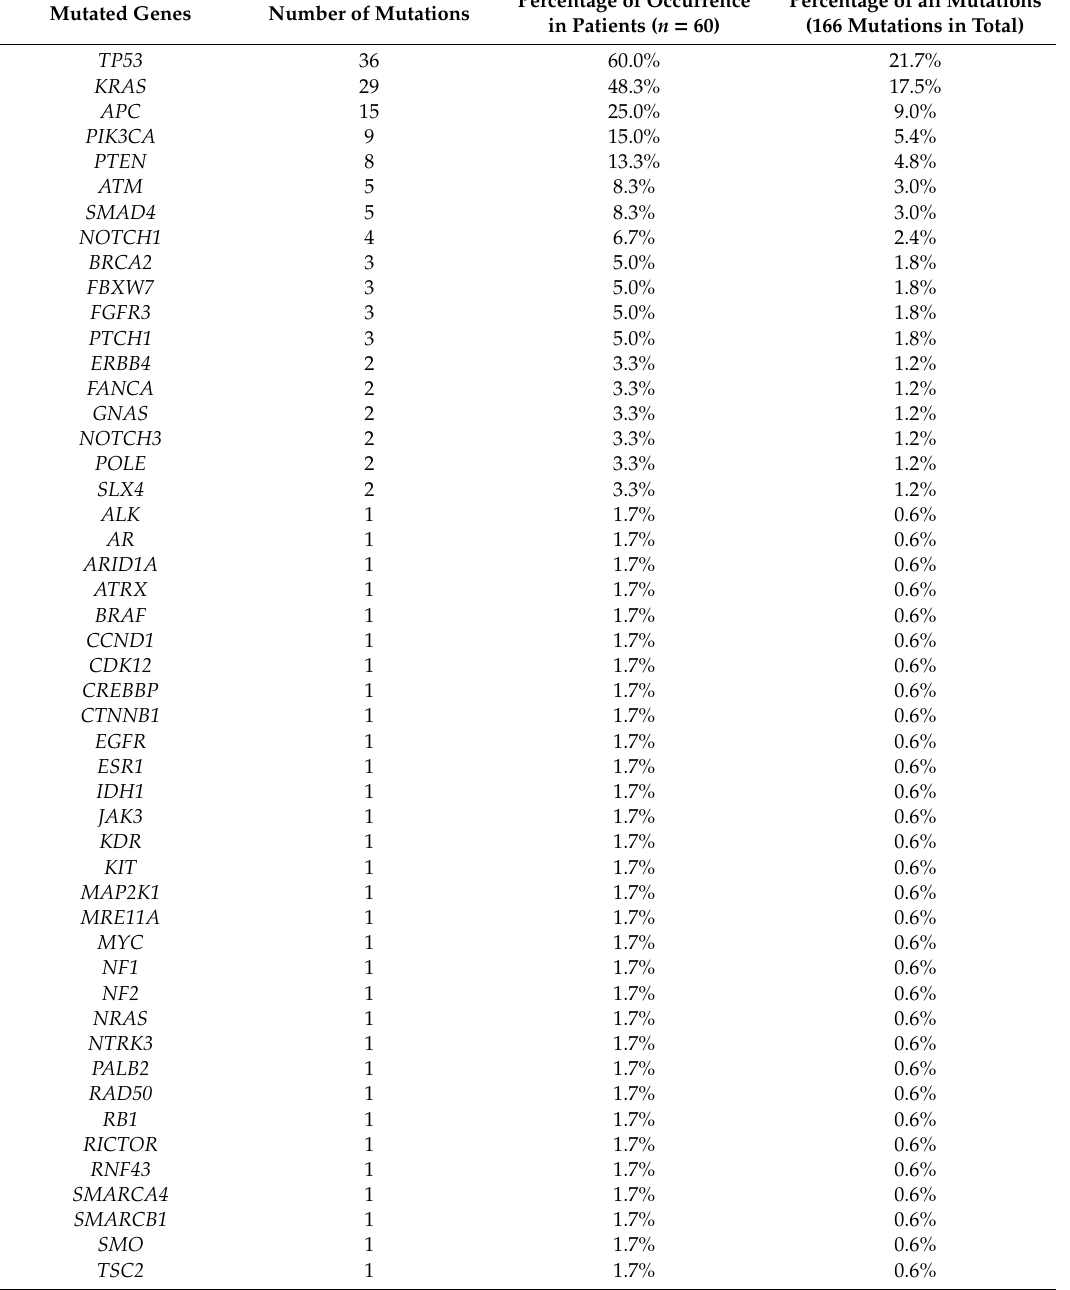
Table 2. Genomic profile of the therapy refractory CRC patients ( n =